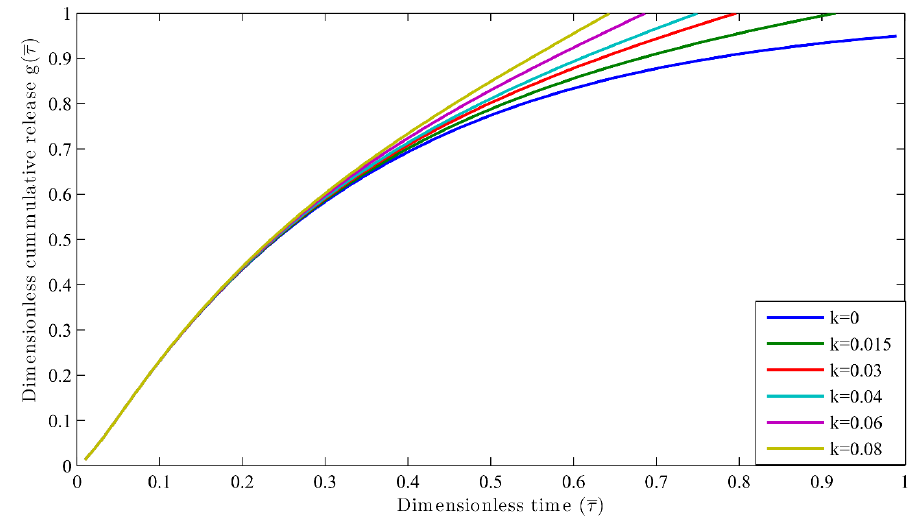
Figure 2. Dimensionless cumulative release versus dimensionless time for different diffusion coefficients.